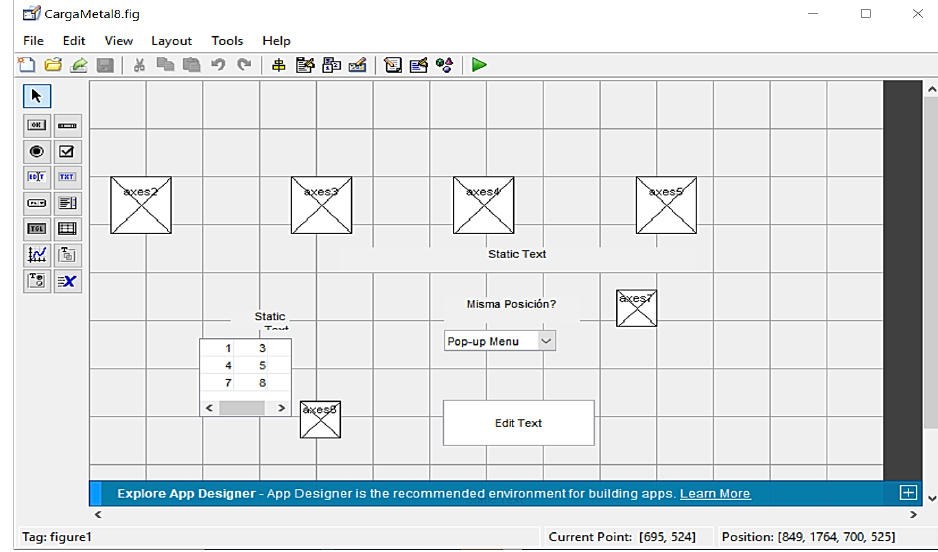
Figure 2. Mental Workload Graphical User Interface MATLAB© ™ interface GUIDE. Source: Authors.